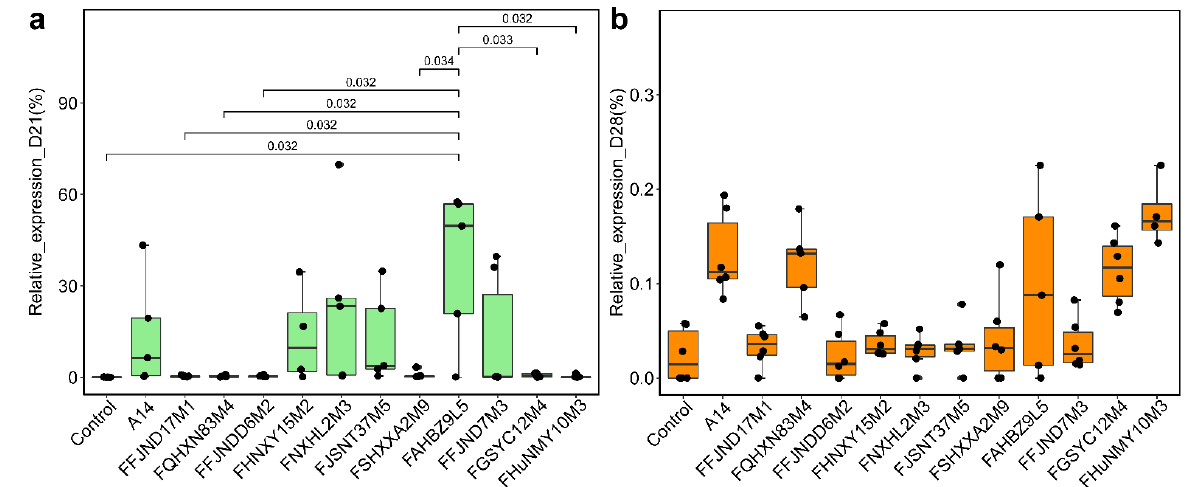
Figure 5. Comparison of different genus in fecal microbiota among groups of mice at different time points (D21, 21 days; D28, 28 days; the relative abundance of genus Akkermansia ( a , b ), Bifidobacterium ( c , d ), Lactobacillus ( e , f )). Different lowercase letters mean that there is a statistically significant dif- ference between 13 groups at a probability level of p < 0.05.